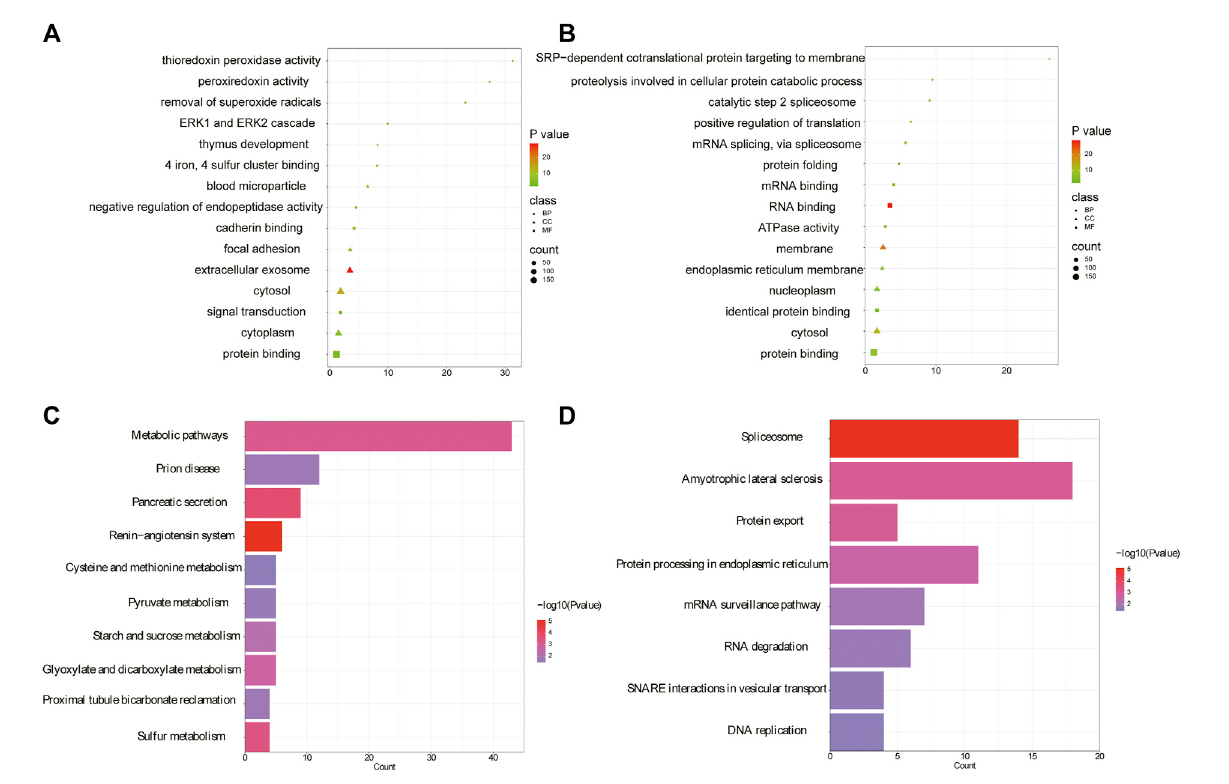
FIGURE 7 Analysis of GO and KEGG of differential mRNAs. (A) The top fi ve enrichments from Go terms (BP/CC/MF) for upregulated mRNAs. (B) The top fi ve enrichments from Go terms (BP/CC/MF) for downregulated mRNAs. (C) KEGG pathway network diagram for upregulated mRNAs. (D) KEGG pathway network diagram of downregulated mRNAs. (GO, gene ontology; KEGG, kyoto encyclopedia of genes and genomes; BP, biological processes; MF, molecular function; CC, cellular